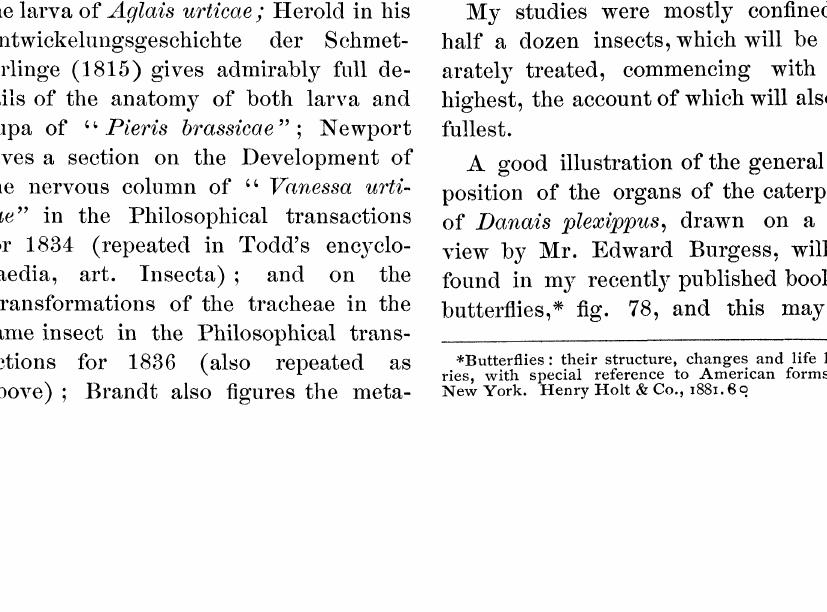
fig. 78, and his may be as *Butterflies their structure, changes and life histo- ries with special reference to American forms above) NwYok.